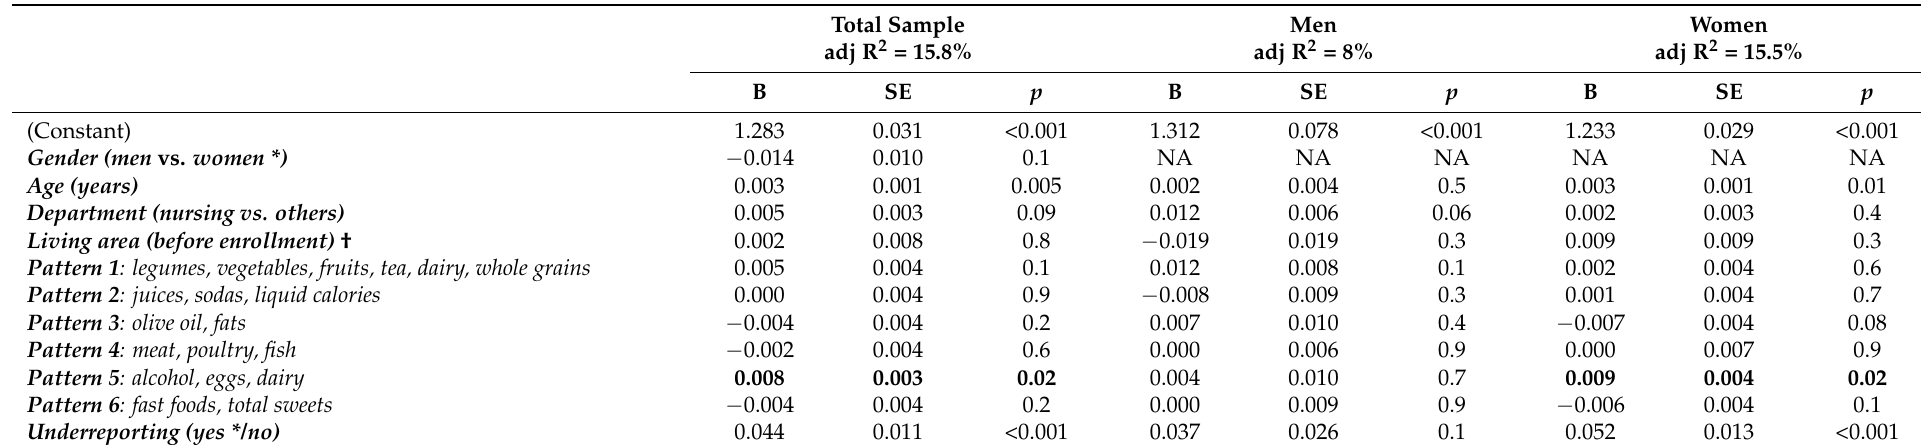
Table 3. Linear regression analysis for logBMI in the total sample, men, and women.